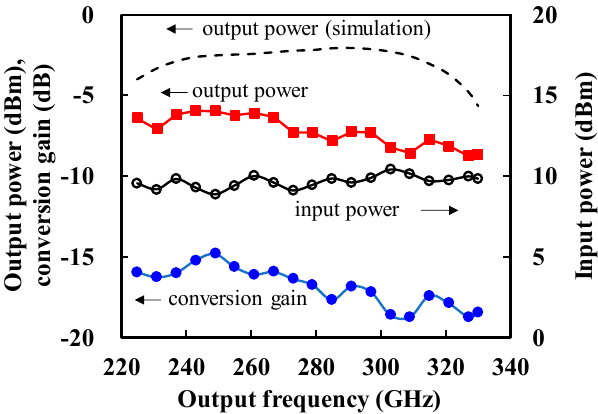
Figure 6. Measured output power and conversion gain of the frequency tripler at an input power around 9.6 dBm.